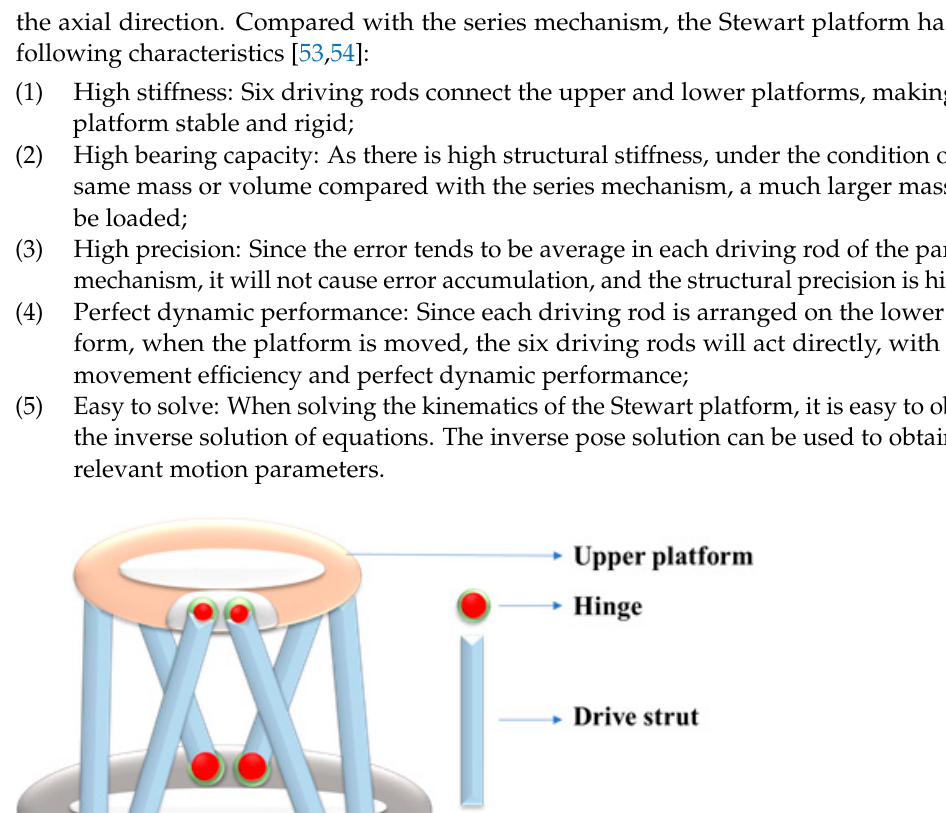
Figure 8. Development history of the Stewart Platform [31,49–52].